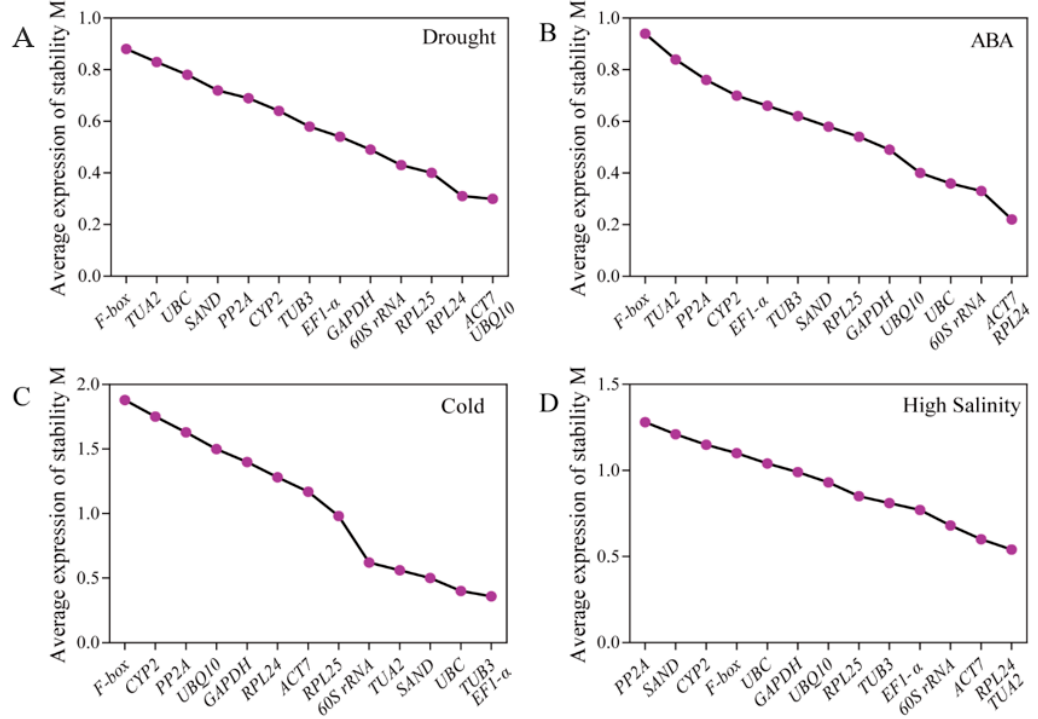
Figure 2. Average expression stability value (M) and ranking of the fourteen RGs across all stresses and ABA treatment calculated using geNorm. ( A ) Drought stress, ( B ) ABA treatment, ( C ) cold stress, and ( D ) high salinity stress. The least stable genes are listed on the left, and the most stable genes are listed on the